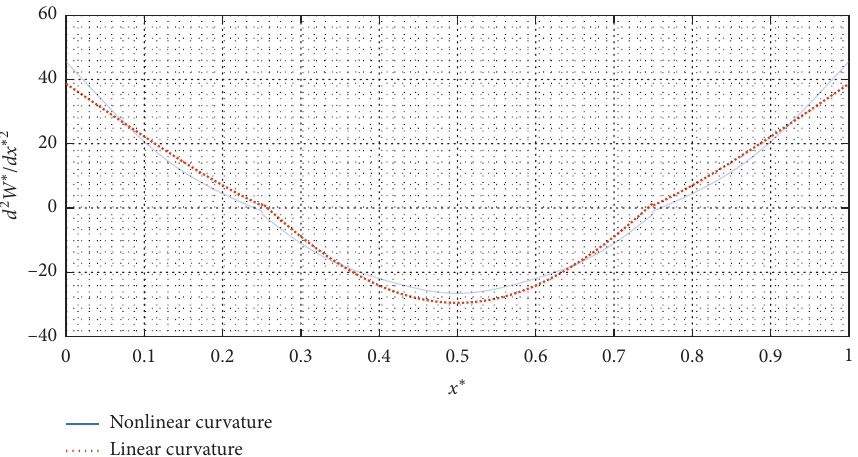
Figure 7: The curvature distribution of beam (a). Maximum nondimensional amplitudes ( W ∗